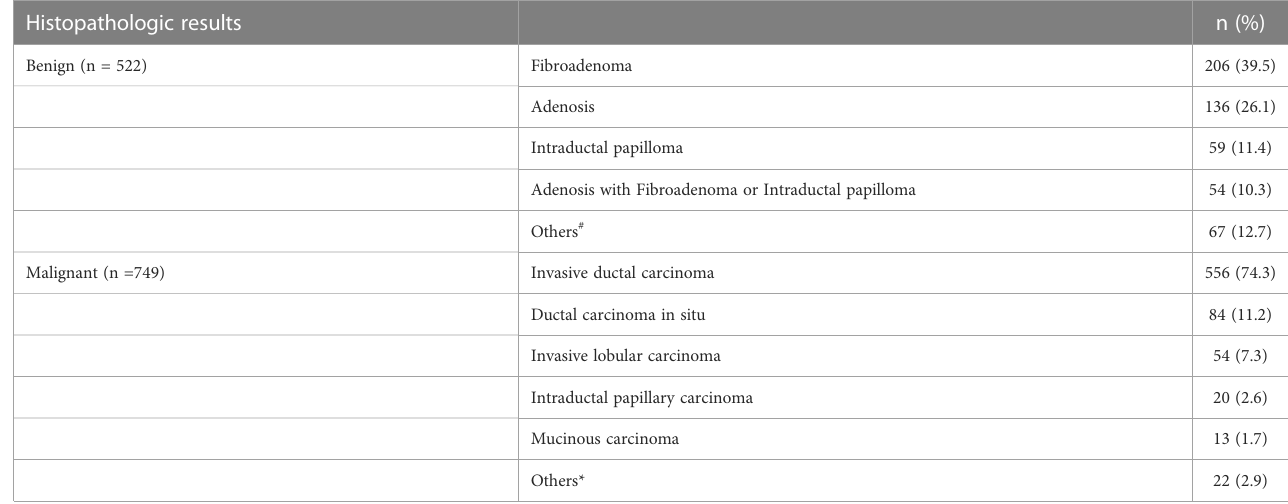
TABLE 2 Summary of pathologic fi ndings. Histopathologic